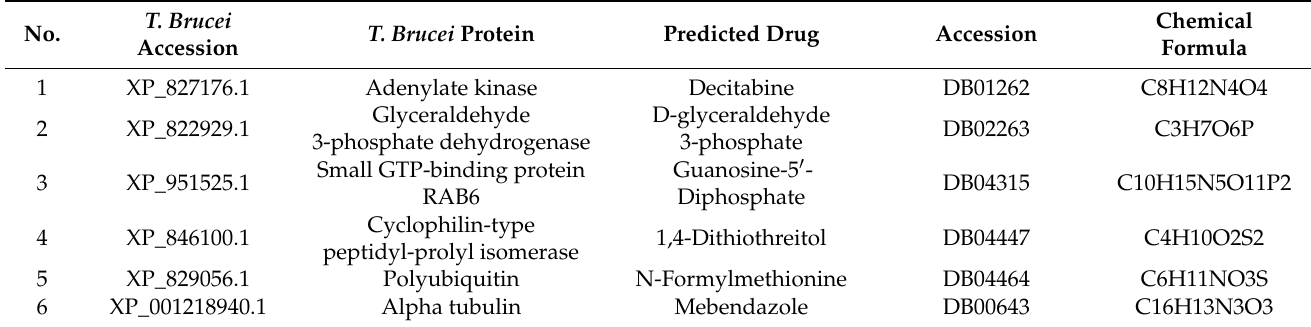
Table 5. Drug target analysis of T. brucei